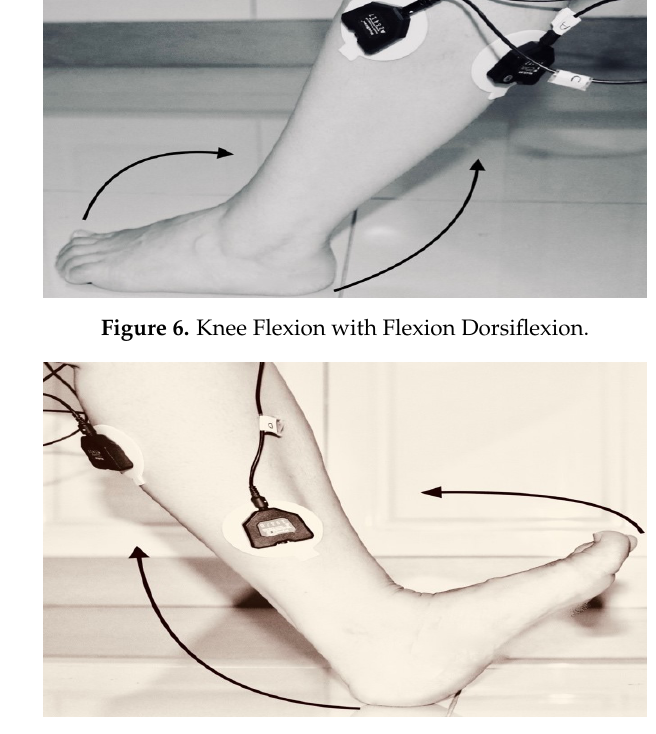
Figure 7. Knee Flexion with Flexion Dorsiflexion.